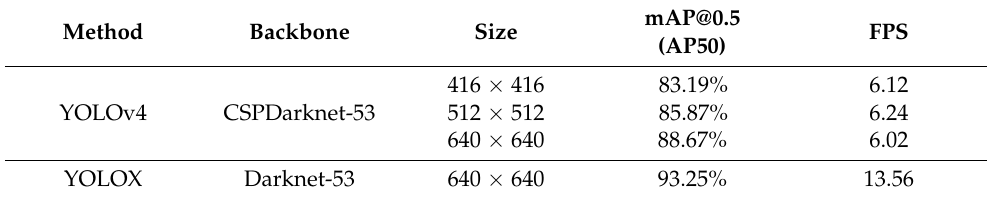
Table 1. Performances of YOLOv4-Tiny and YOLOX with respect to different resolutions.